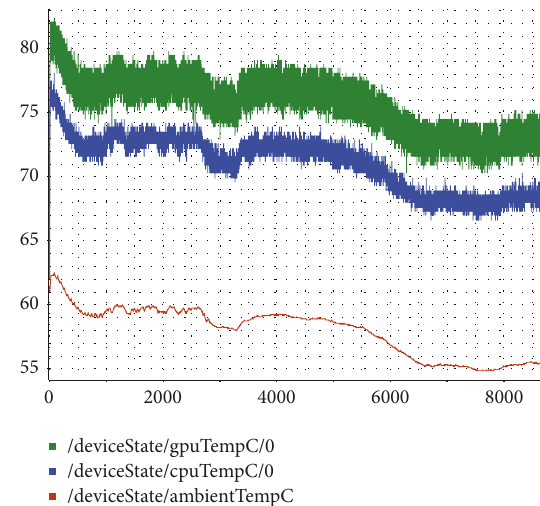
Figure 41: T2D1 left (1) and right (2) lane recognition.